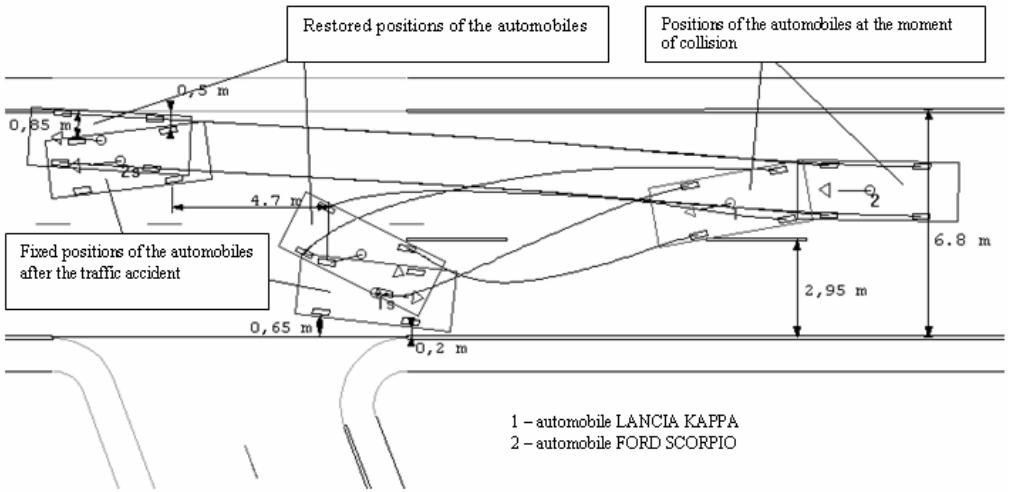
Fig 3. Collision of the automobiles LANCIA KAPPA and FORD SCORPIO